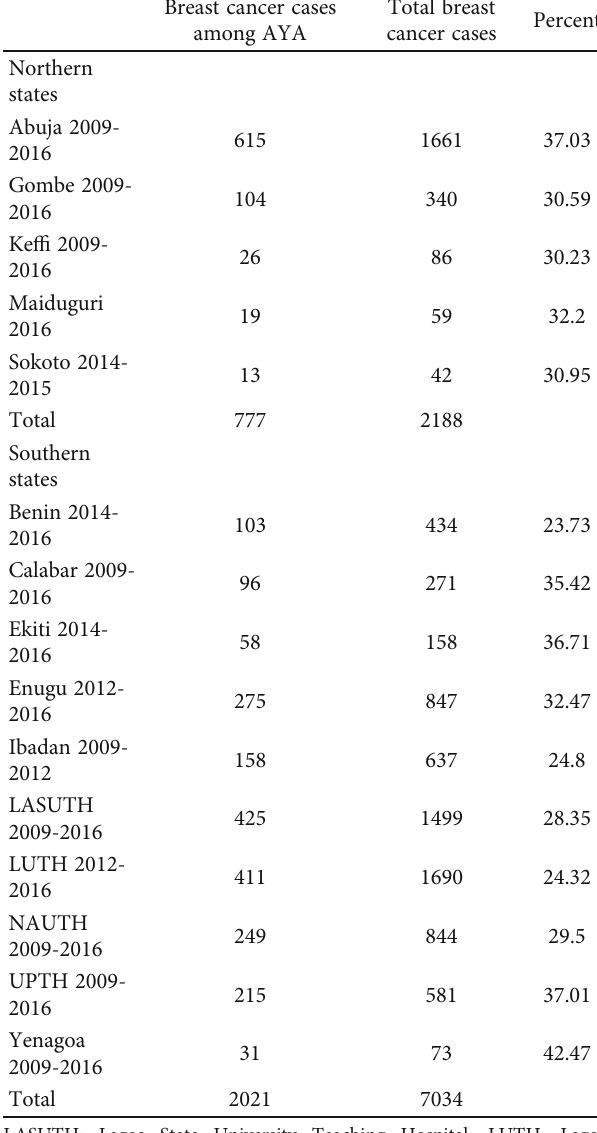
Table 3: Proportion of breast cancer cases among female AYAs (15-39 years) in 15 cancer centers in Nigeria from 2009 to 2016. Breast cancer cases